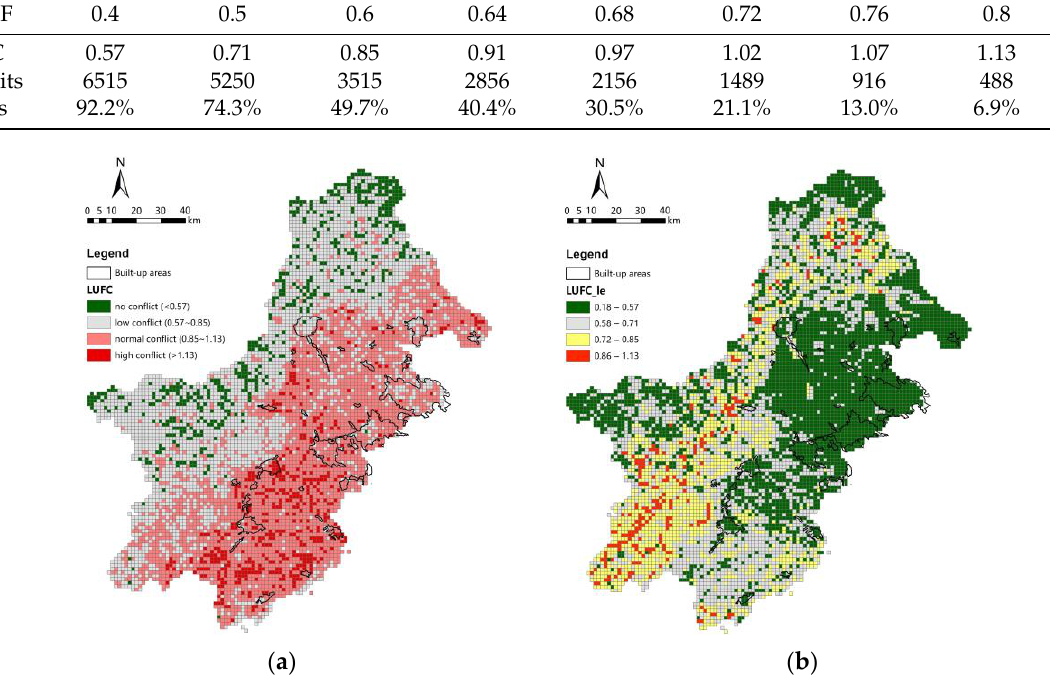
Figure 5. Distribution of land-use function suitability conflict. (a) Considering production–living– ecological conflict and (b) only considering living–ecological conflict.